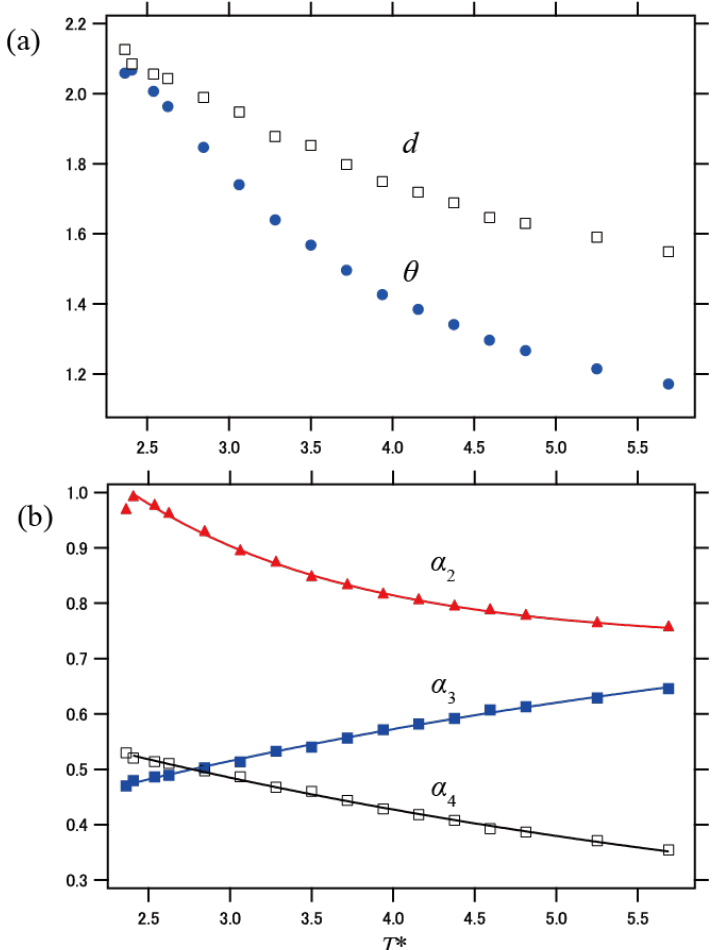
Figure 5. Temperature dependence of exponents; ( a ) d and θ , and ( b ) α for different cases, i.e., α 2 = θ / d , α 3 = 1/ d , and α 4 = ( d − 1)/ d . The solid curves in ( b ) represent the fitting results based on an empirical expression as described in the Supplementary Materials.